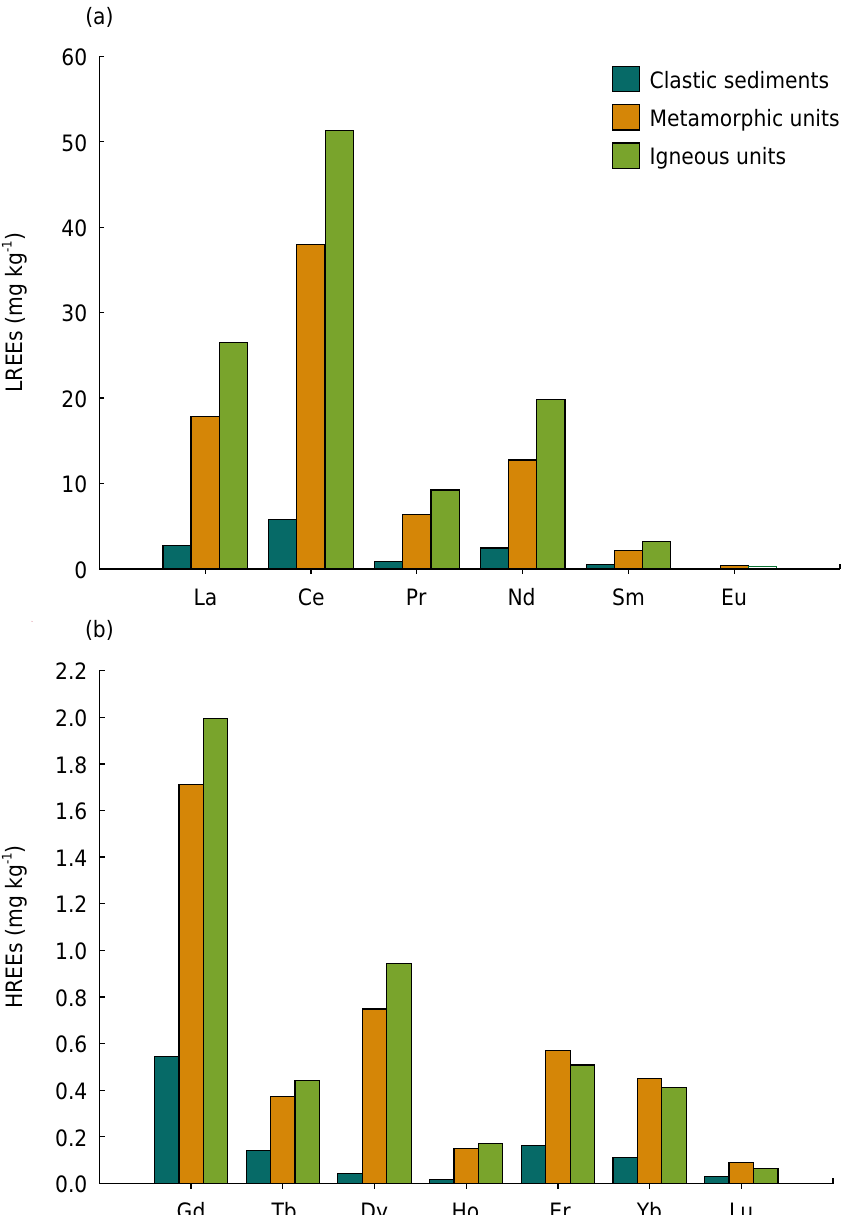
Figure 3. Light rare earth elements in soils derived from different parent materials in the sub-humid zone of the state of Rio Grande do Norte, Northeast Brazil (a). Heavy rare earth elements in soils derived from different parent materials in the sub-humid zone of the state of Rio Grande do Norte, Northeast Brazil